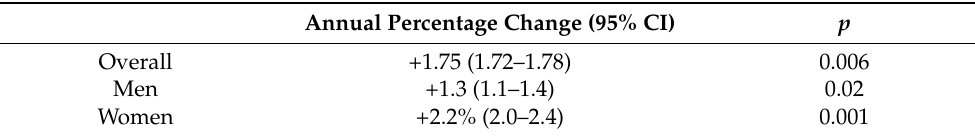
Table 1. Trends in Takotsubo (TTS) event rates also stratified by gender between 2018 and 2020. CI: confidence